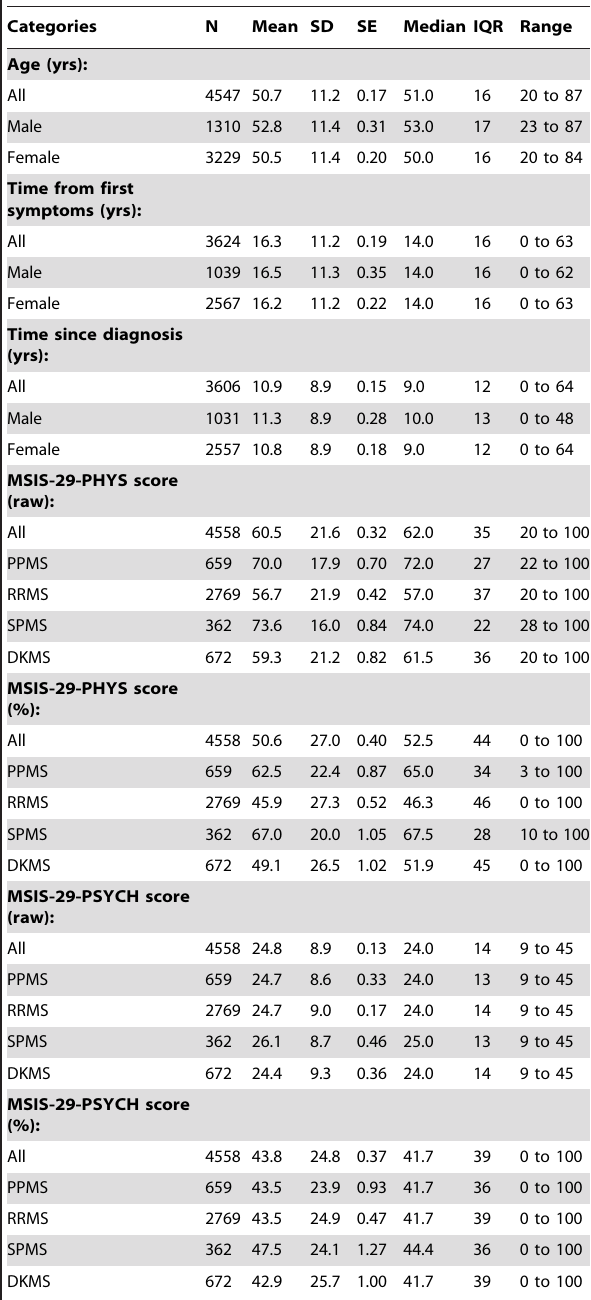
Table 1. Timelines and MSIS-29 scores of the cohort.